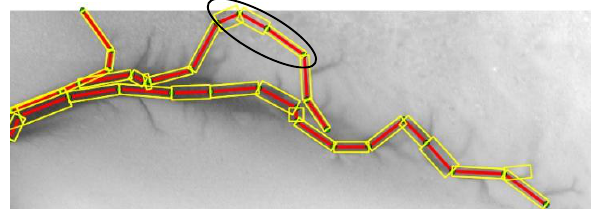
Figure 5: If we reduce the weight for the data energy, also smaller tidal channels are detected. However, they are wrongly connected.